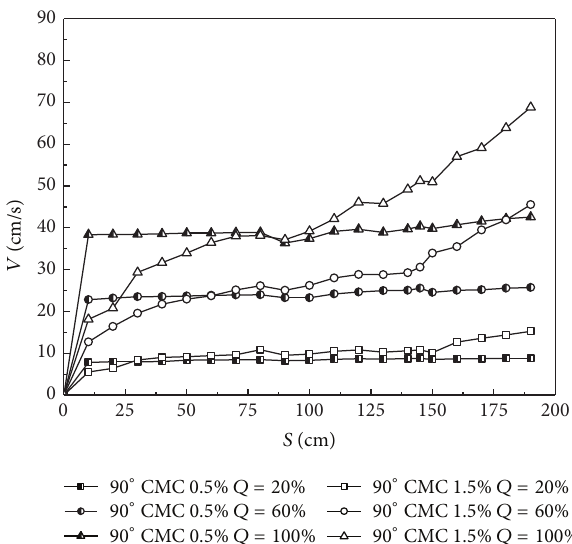
Figure10:ThePAAvelocity-positiondiagramofvariousflowin135 ∘ curved tube.